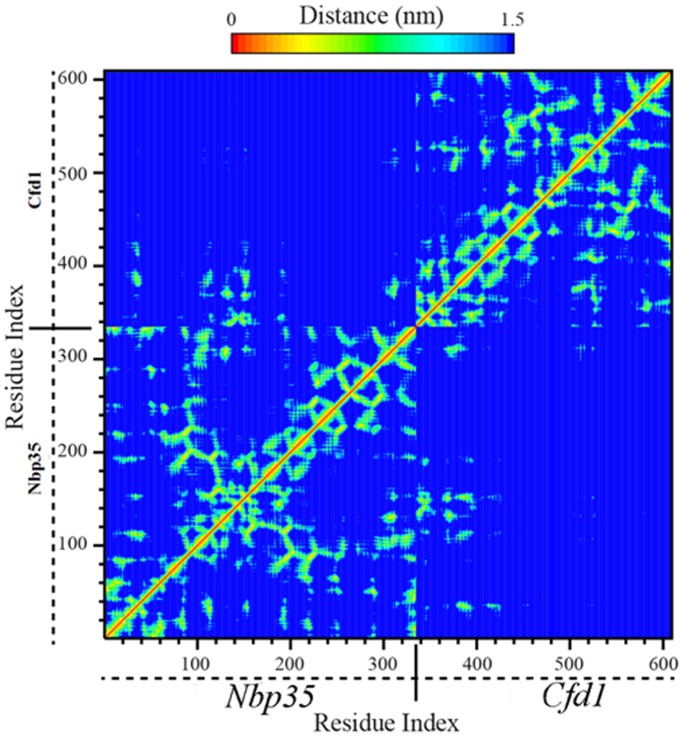
Contact map of Nbp35-Cfd1 complex.The contact map of Nbp35-Cfd1 complex is indicating the cross residue region involved in contact of these two proteins.